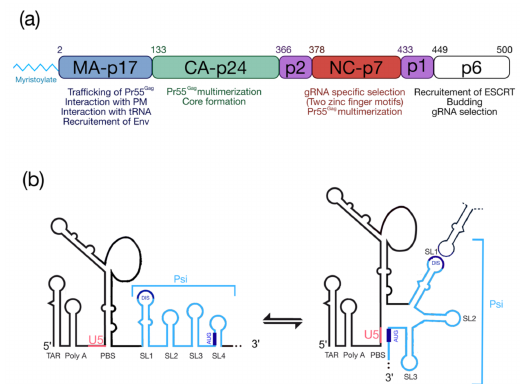
Figure 1. Pr55 Gag and the 5 (cid:48) UTR of HIV-1 genomic RNA. ( a ) Functional domains of Pr55 Gag and a short description of their roles. ( b ) Schematic representation of the secondary structure model of the 5 (cid:48) UTR (adapted from [29]). TAR: transactivation response element; Poly-A: 5 (cid:48) -copy of the polyadenylation signal; PBS: Primer Biding Site; DIS: Dimerization Initiation Site; Psi: packaging signal spanning SL1 to SL4; U5: unique region at the 5 (cid:48) end. The structure represents the U5-AUG conformation